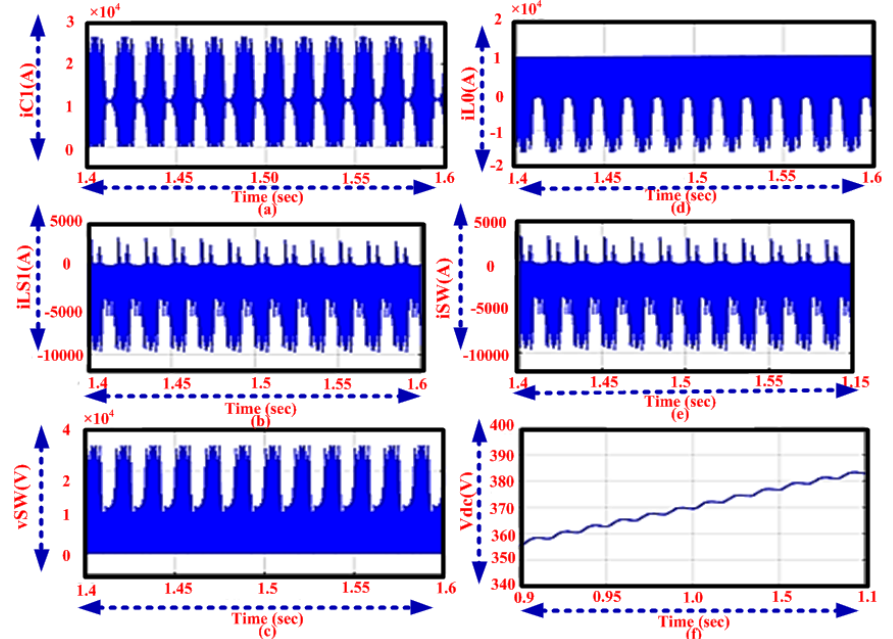
Figure 9. Analysis of current using the ( a ) C 1 , ( b ) L 1 , ( d ) L 0 , ( e ) switch and voltage using ( c ) switch, ( f ) DC-link.